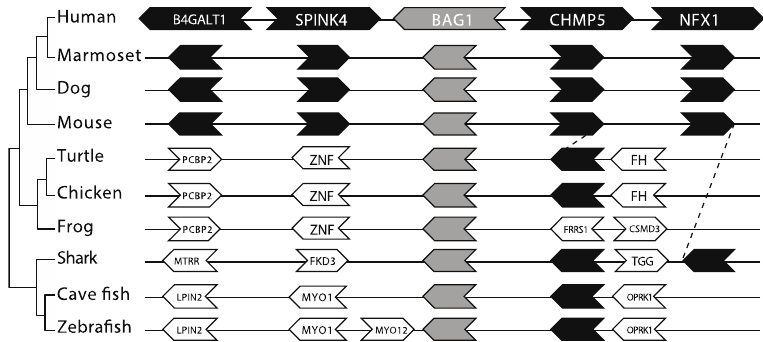
Figure 4. The genomic organization of the BAG1 loci is relatively conserved within vertebrates. Genes flanking the BAG1 loci were collected from GenBank. Filled arrows represent orthologs of genes flanking the human BAG1. Open arrows represent other genes surrounding the BAG1 loci in each representative species. Each arrow’s direction represents the gene’s transcription orientation. The graph is not in scale for clarity.